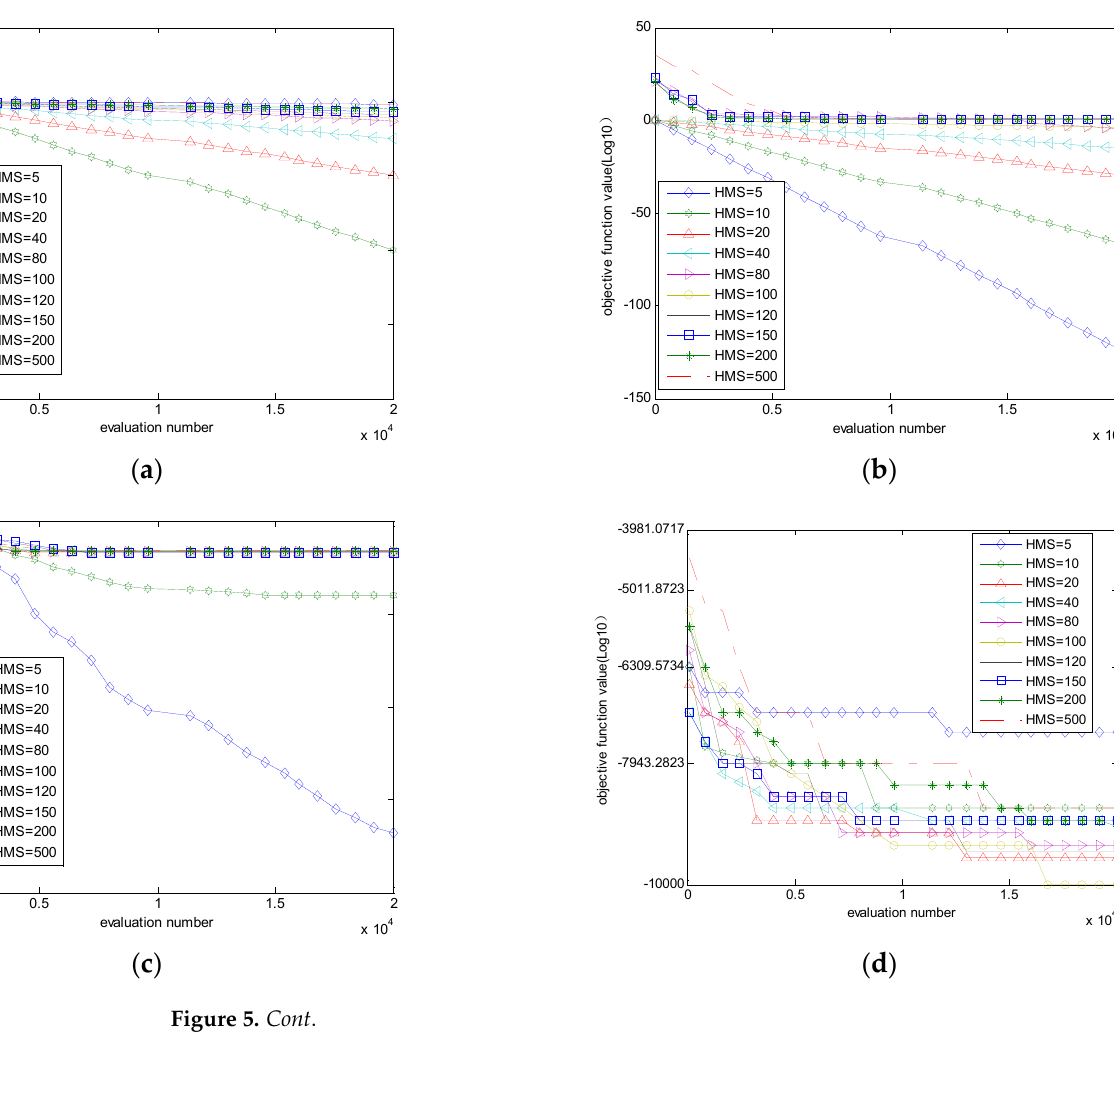
1 ; ( b ) f 2 ; ( c ) f 3 ; ( d ) f 4 ;